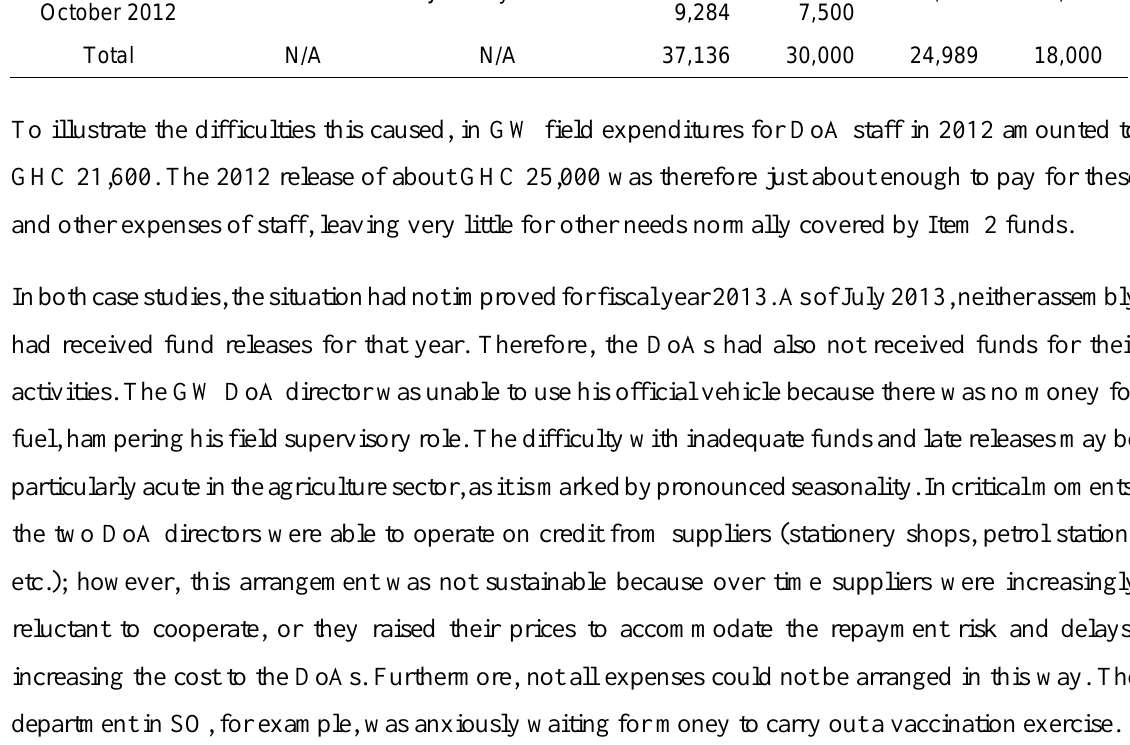
Table 2: Discrepancies in the 2012 quantity and timing of agricultural finances to the two districts Periodicity Amount (GHC) Planned Actual Planned Actual GW SO GW SO GW SO January 2012